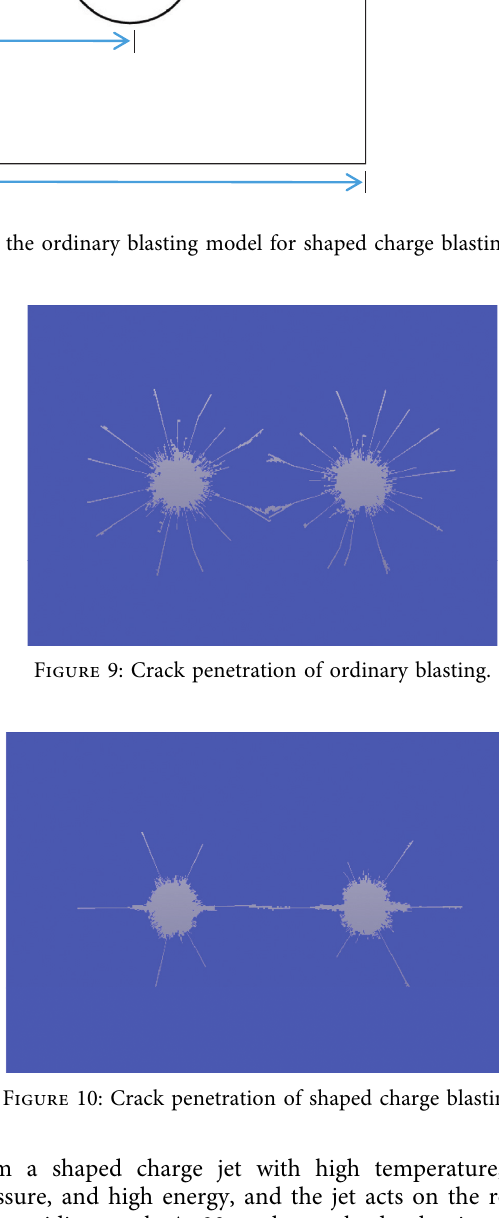
Figure 8: Crack development at 30 μ s of shaped charge blasting.